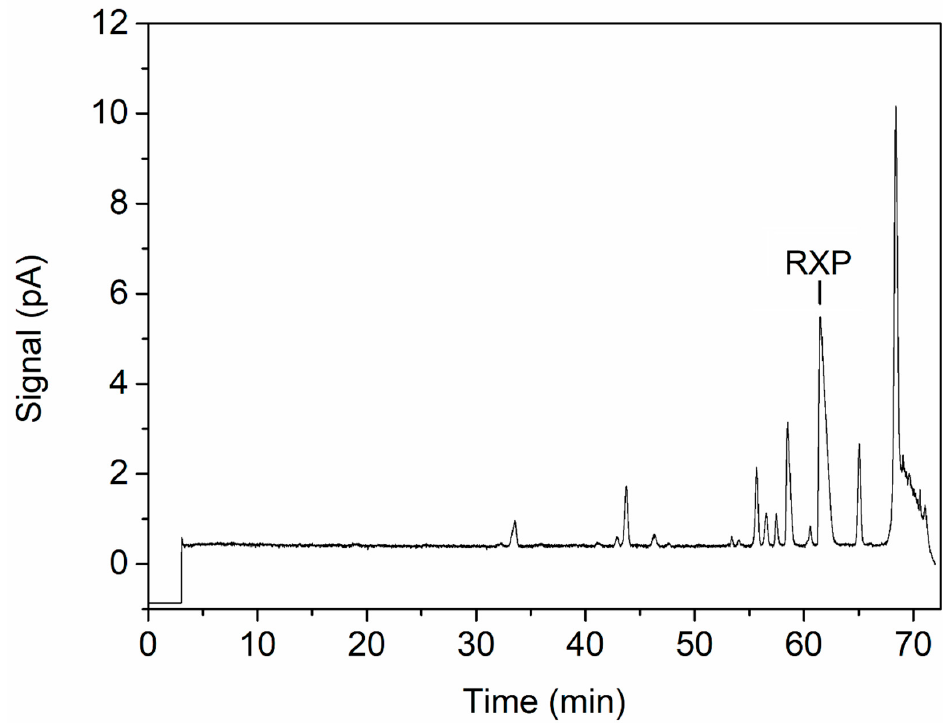
Figure 8. UHPLC chromatogram of the optimized method (1% ( v / v ) formic acid, 50 °C and a gradient slope of 0.5% min − 1 ), showing the RXP and separated byproducts of VietABC.